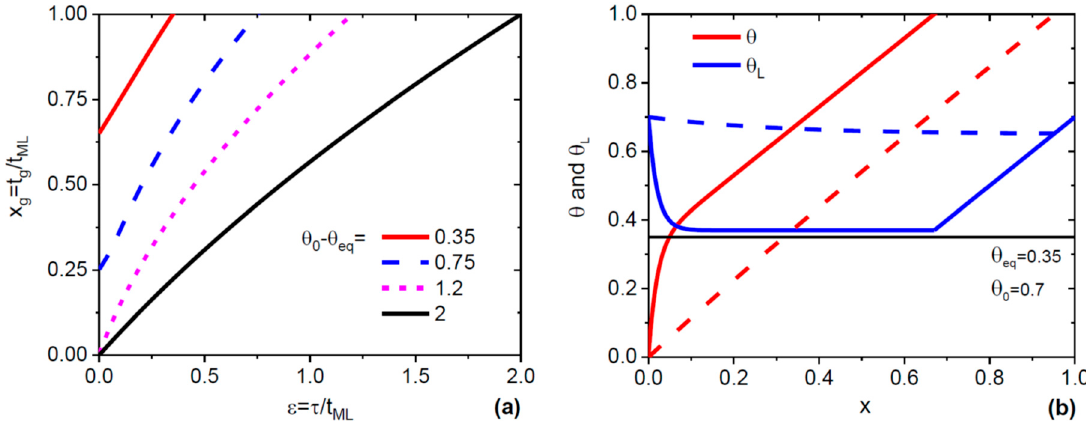
Figure 1. ( a ) Normalized monolayer (ML) growth time x g as a function of ε for four di ff erent values of θ 0 − θ eq given in the legend, without As desorption. At the largest θ 0 − θ eq = 2, x g starts from zero and increases almost linearly with ε , reaching unity at ε max . The curve at θ 0 − θ eq = 1.2 is more non-linear but follows the same trend. Due to the stopping e ff ect, x g is nonzero at θ 0 − θ eq < 1. ( b ) One oscillation of the ML coverage and As content in liquid at ε = 0.02 (solid lines) and ε = 0.3 (dashed lines). Di ff erent time scales of the fast and slow growth stages are clearly seen at ε = 0.02, where θ L stays just slightly above equilibrium ( θ eq = 0.35 is indicated by the horizontal line) for a long time. At ε = 0.3, the ML growth rate is very close to the rate of refill, while θ L remains almost constant over the ML formation cycle.